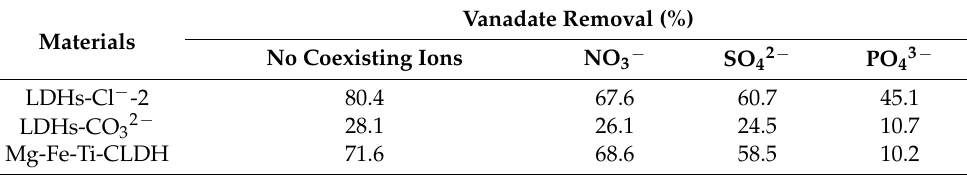
Table 6. Effect of coexisting ions on Mg-Fe-Ti-LDHs-Cl − -2, Mg-Fe-Ti-LDHs-CO 3 2 − and Mg-Fe-Ti- CLDH adsorption of VO 3 − .